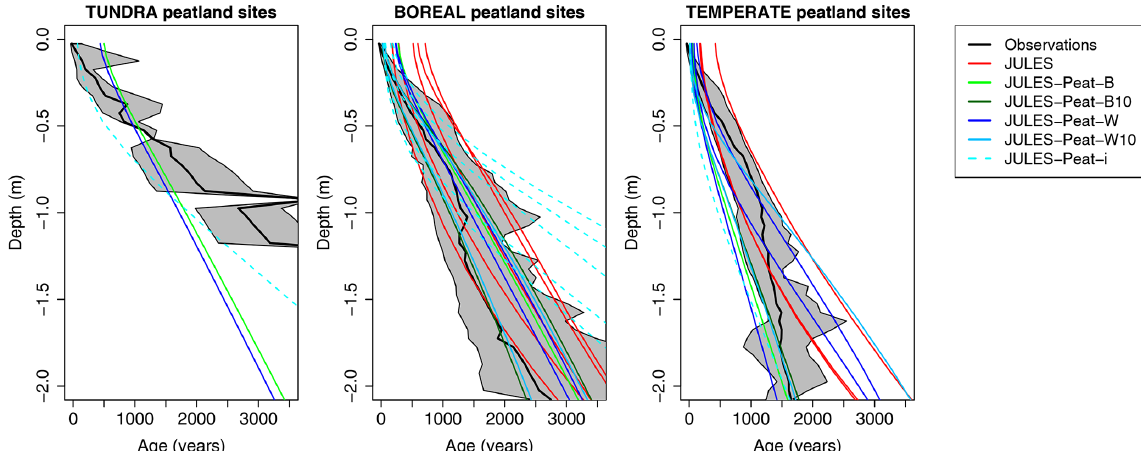
Figure 6. Evaluation of JULES-Peat age–depth profile against the median profile from peat cores. The grey-shaded area shows the interquar- tile range. Only sites where the model simulates a sufficiently thick organic layer to classify it as peat ( > 15% carbon by mass for ≥ 39cm, see Sect. 3) are shown. The sites that are shown for each simulation are highlighted in bold in Table S4.